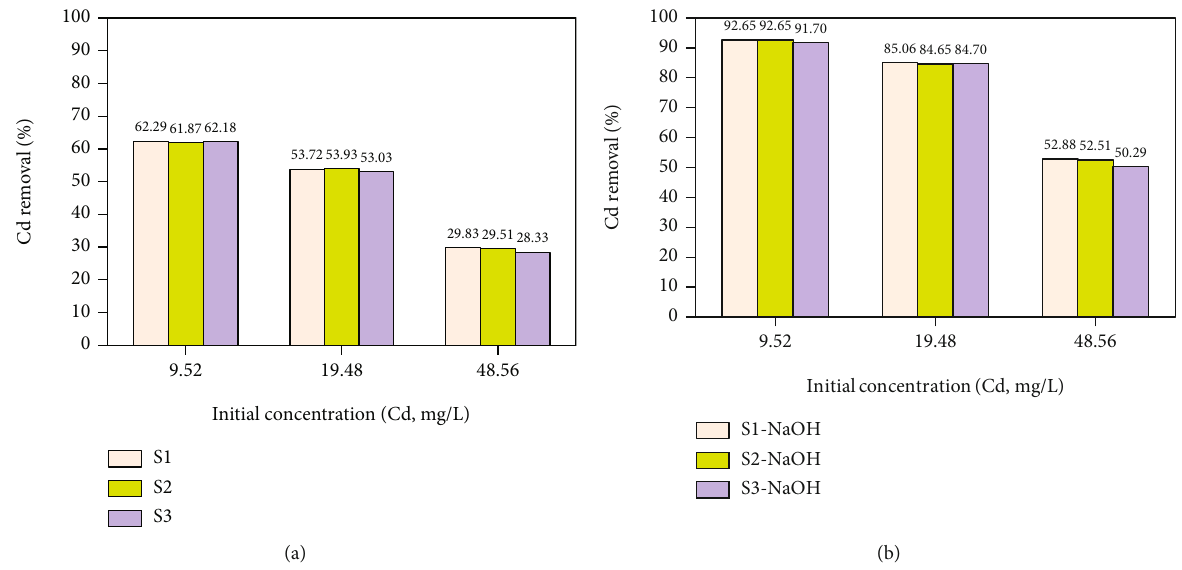
Figure 8: E ff ect of initial Cd concentration on removal percentage: (a) untreated rice husk and (b) NaOH-treated rice husk ( pH = 7 , adsorbent dosage = 150mg , and rice husk size S1: < 212-425 μ m > , S2: < 425-600 μ m > , and S3: < 600-850 μ m >